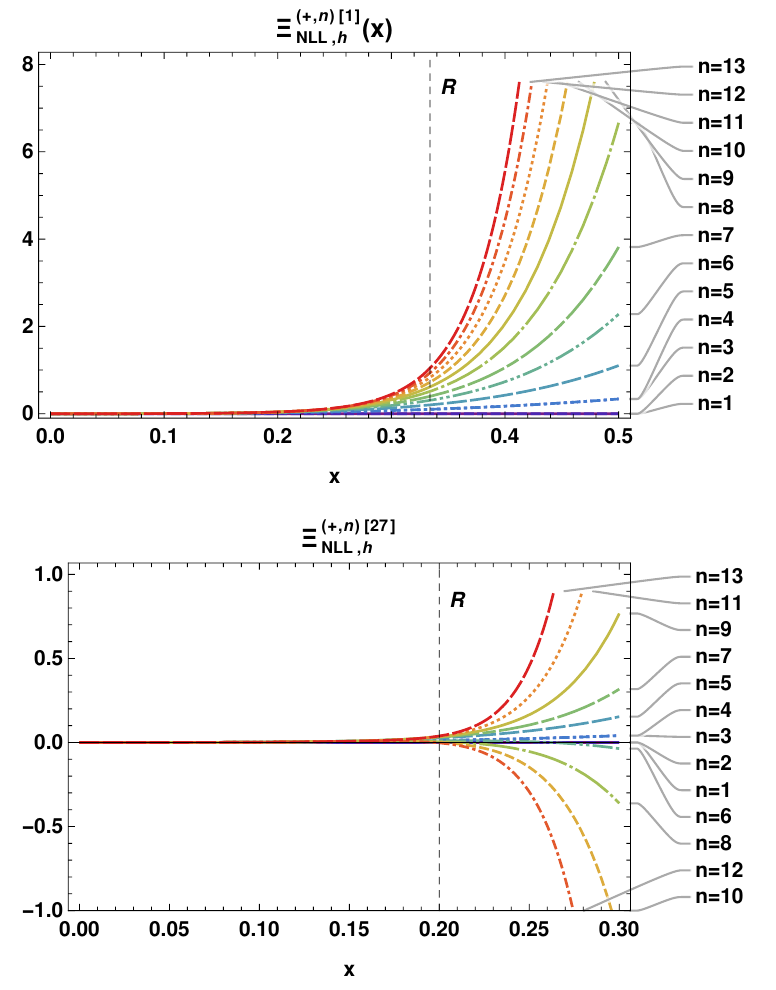
Figure 11 . Partial sums of the hard component of the infrared-renormalized amplitude coe(cid:14)cients (cid:4) (+ ;‘ ) , up to 13th order, for the singlet (upper plot) and 27 colour representation (lower plot). NLL ; h The dashed vertical line represents the radius of convergence, R , determined by the pole closest to x = 0, using the method of Pad(cid:19)e